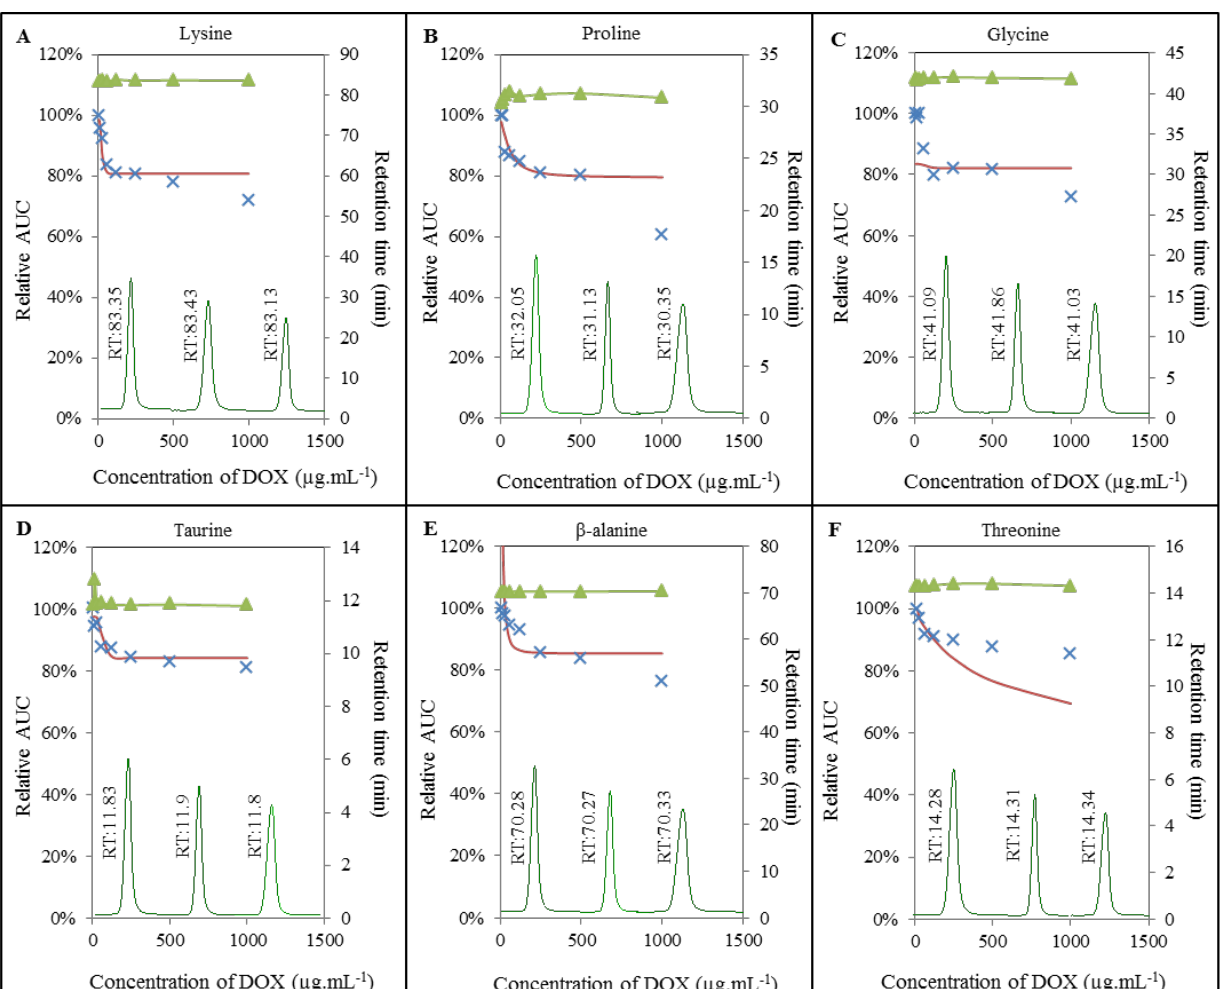
Figure 4. Interaction of amino acids (100 µmol mL −1 ) with doxorubicin (8; 16; 32; 64; 125; 250; 500; 1000 µg mL −1 ) monitored with IELC. DOX interaction with: ( A ) lysine; ( B ) proline; ( C ) glycine; ( D ) taurine; ( E ) β-alanine; ( F ) threonine. ▲ Expression